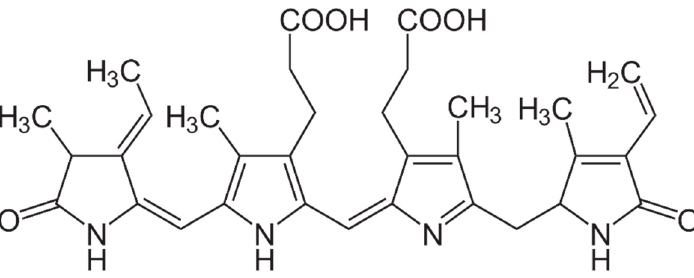
Cosmetics 2018 , 5 , x FOR PEER REVIEW Figure 8. Phycoerythrobilin is the typical chromophore in phycoerythrin. Figure 8. Phycoerythrobilin is the typical chromophore in phycoerythrin.